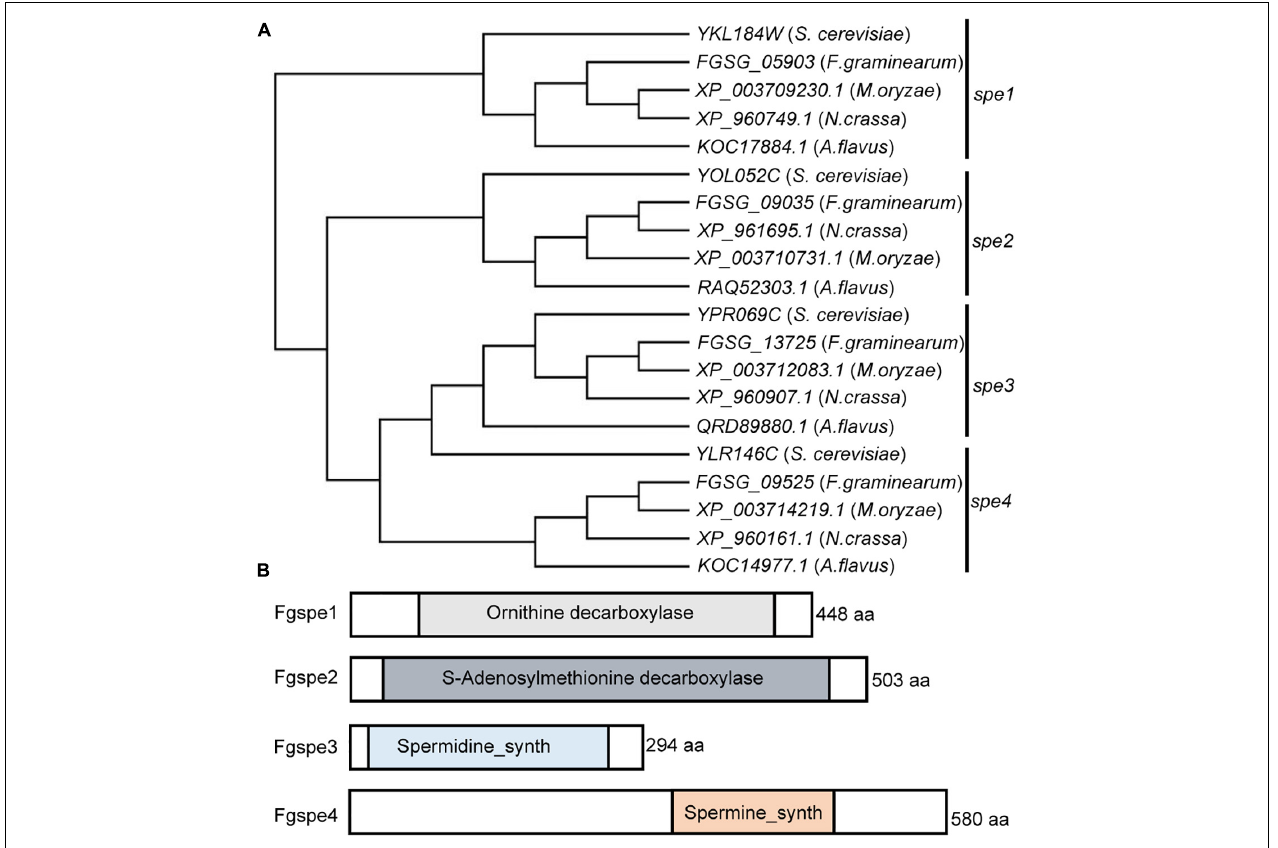
FIGURE 1 | Identification of the Fgspe proteins in F. graminearum . (A) Phylogenetic analysis of SPEs from F. graminearum , S. cerevisiae , and other filamentous fungi. Protein sequences of Fgspe1–4 paralogues were aligned by CLUSTALW, and a neighbor-joining tree was constructed by MEGA 7.0. The names of all proteins are shown in the figure. (B) Schematic drawing of Fgspe superfamily proteins members in F. graminearum . Conserved domains are indicated in the figure.